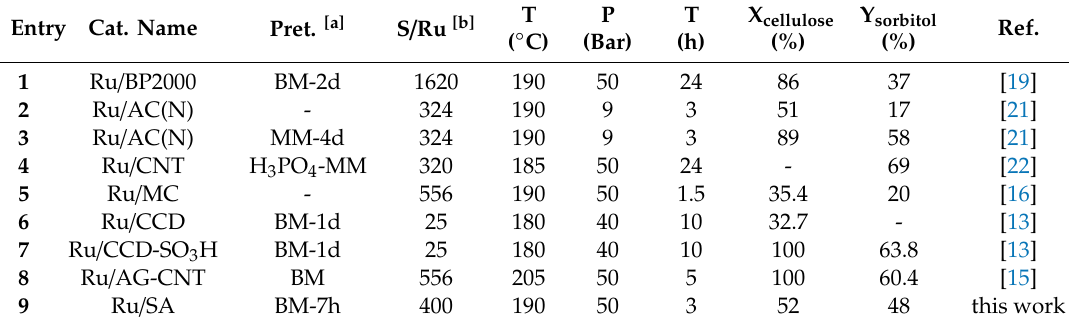
Table 5. Summary of reported results in the hydrolytic hydrogenation of cellulose, using carbon supported Ru